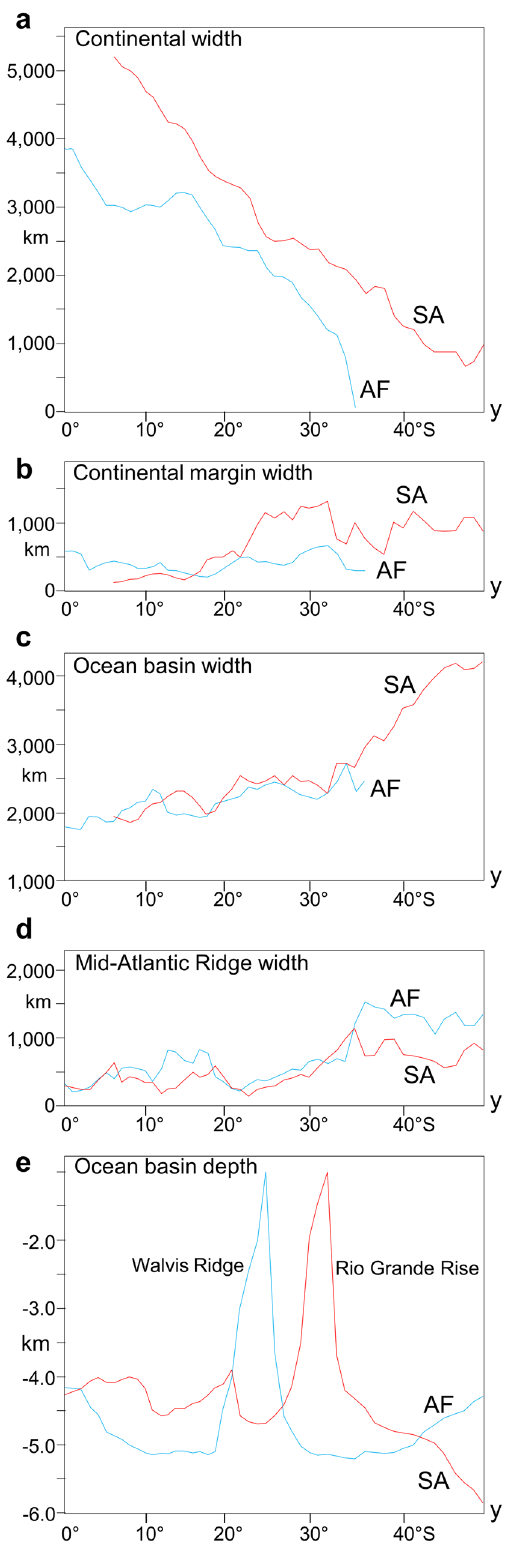
along-axis variations in asymmetry and non-uniformity in Atlantic opening that have been contentious 51 – 56 (Supplementary Fig. 5).